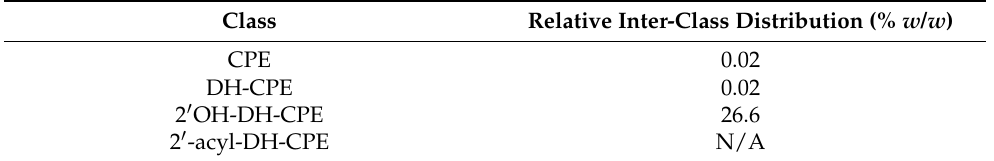
Table 1. Concentrations (% w / w ) of ceramide classes CPE, DH-CPE, and 2 (cid:48) OH-DHCPE of total lipid extract from Tannerella forsythia